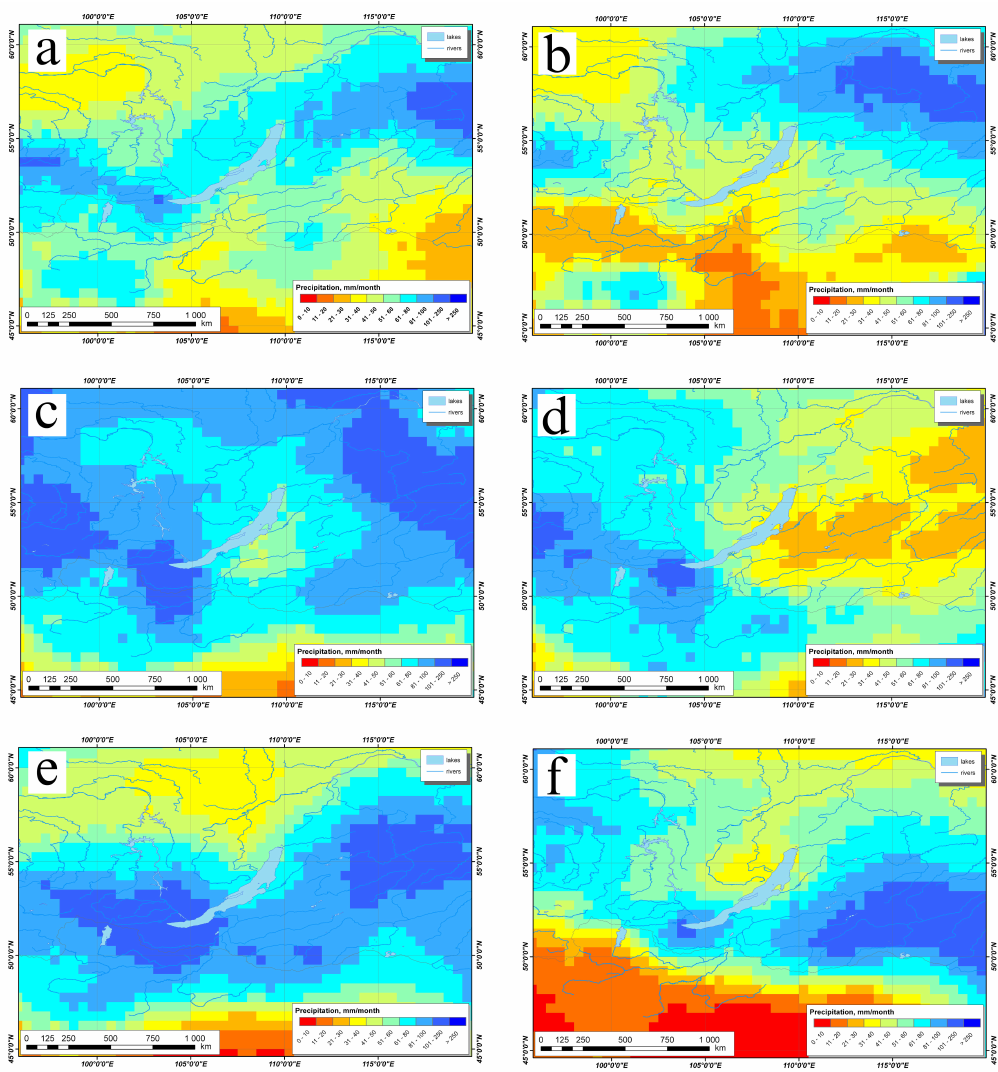
Figure 7. The comparison between the spatial distribution of CRU TS (Climatic Research Unit) monthly precipitation (mm / month) in the relative wet 2010 summer ( a , c , e ) and in the abnormally dry 2015 summer ( b , d , f ) is shown. Panels ( a,b ) correspond to June, ( c , d ) correspond to July, and ( e , f ) correspond to